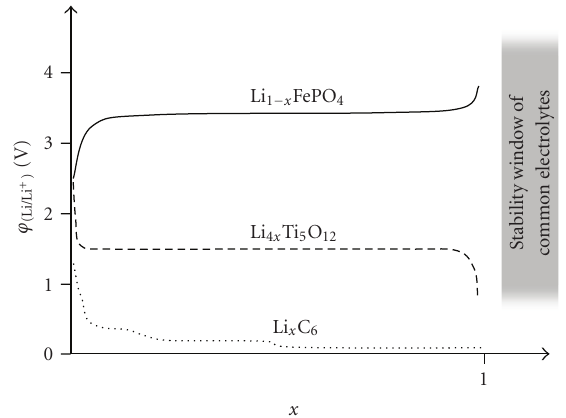
Figure 1: Potential against Li/Li + of three di ff erent electrode materials, showing two-phase transition, plotted over the lithium content x [12–14].